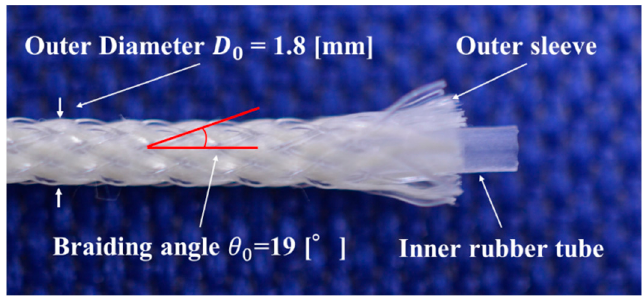
Figure 1. Appearance and structure of the thin artificial muscle.